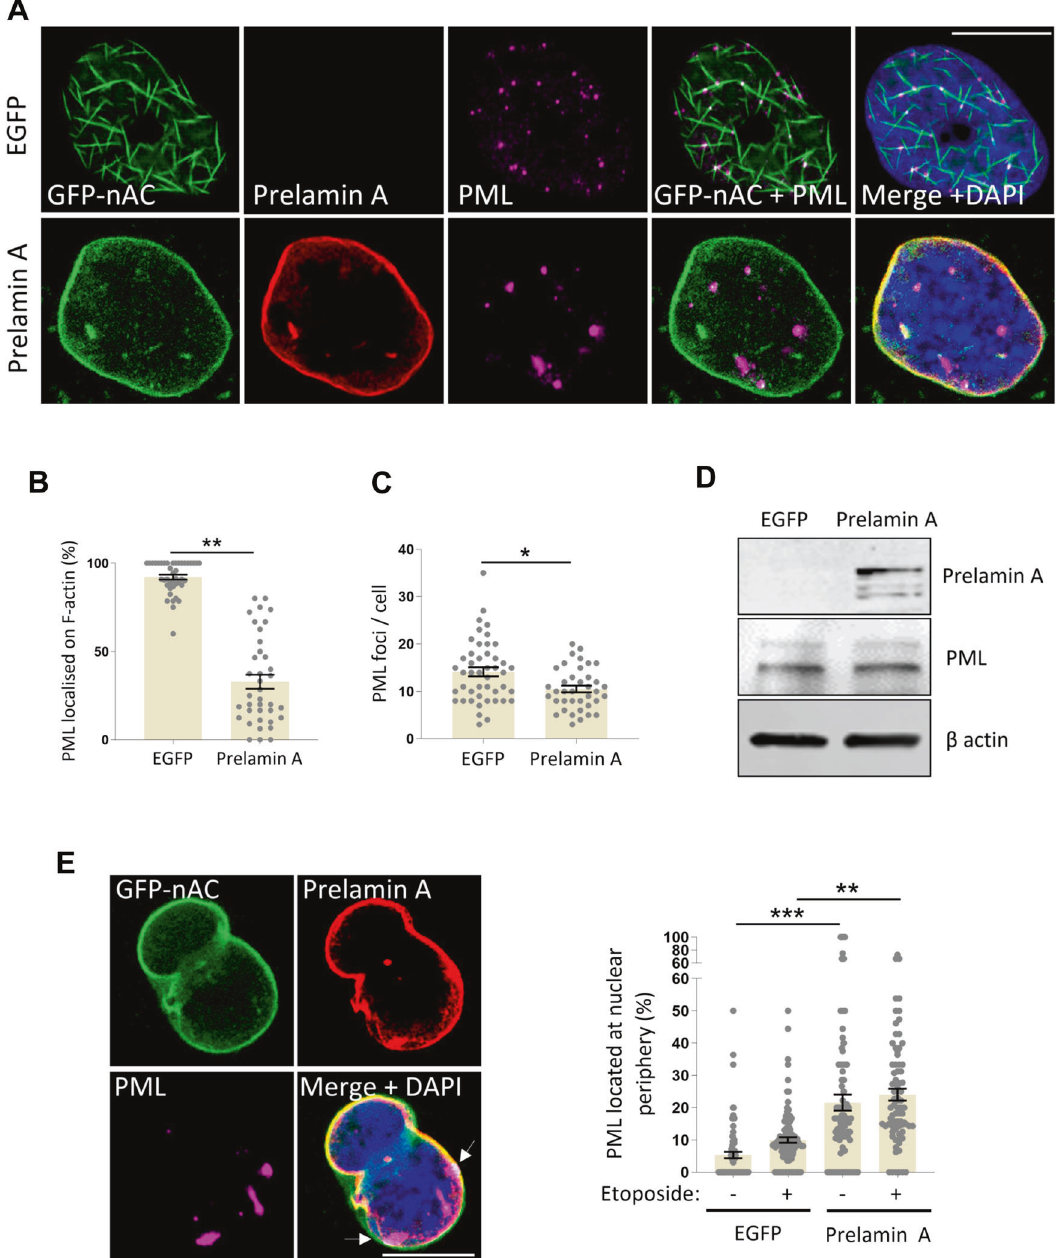
prelamin A and PML NB foci in these cells are less numerous and appear larger compared to prelamin A negative cells. B , C Quanti fi cation PML localisation and enumeration from IF shown in A , n = 5 (>100 cells). D Representative WB showing the expression of prelamin A does not affect the level of PML in U2OS cells (quanti fi cation is shown in Supplement Fig. 4B). E IF data showing that prelamin A expression in U2OS + GFP-nAC cells increases the localisation of PML NBs at the nuclear periphery (white arrows) with or without additional DNA damage (1 mM etoposide for 3 h). DNA is stained with DAPI (blue), n = 4 (>100 cells). Data were presented as mean ± SEM and were analysed by one- way ANOVA and Tukey ’ s test. * p < 0.05, ** p < 0.01 and *** p < 0.001. Scale bars in IF images = 10